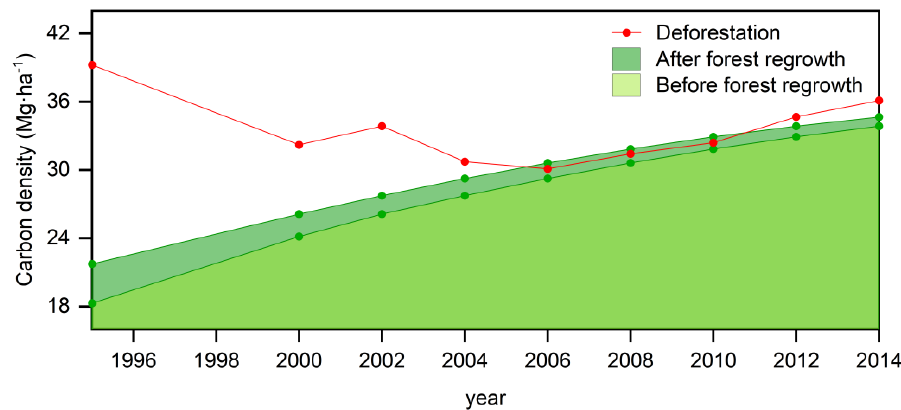
Figure 9. Biennial carbon density profile of variation of deforestation and reforestation.